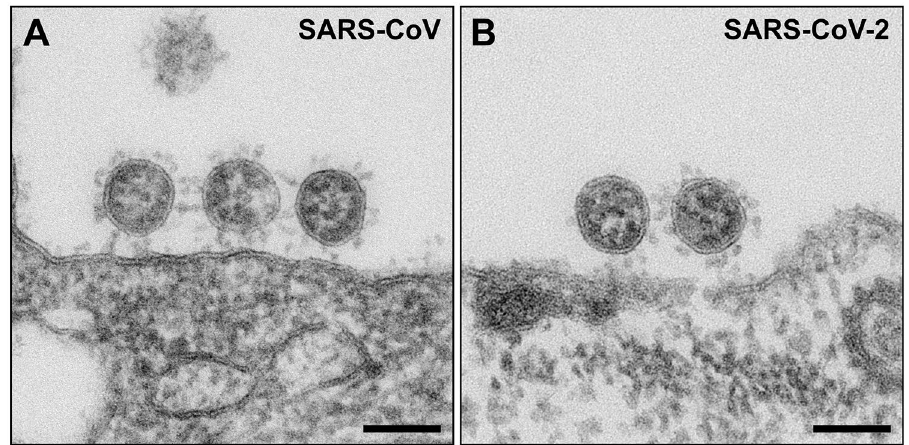
Figure 2. Transmission EM of ultrathin sections through Vero cells which were either infected with SARS- CoV ( A ), or with SARS-CoV-2 ( B ). Viruses are attached to the surface of the cells and do not reveal substantial differences in their ultrastructure. Scale bars = 100